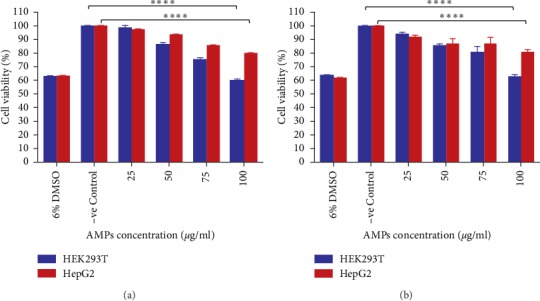
Cytotoxicity of Molecule 3 and Molecule 7 to mammalian cells. (a) Cytotoxicity of Molecule 3 to HepG2 and HEK293T cell lines. (b) Cytotoxicity of Molecule 7 to HepG2 and HEK293T cell lines. Cytotoxicity was measured with an MTT assay. The concentrations of Molecule 3 and Molecule 7 ranged from 0 to 100 μg/ml. The positive control was 6.0% DMSO. The error bars indicate standard deviations from the mean. ∗∗∗∗ Statistical significance (p < 0.001) compared to negative control.